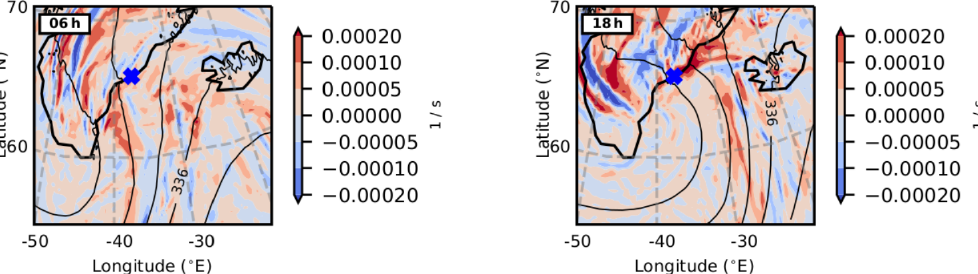
Figure 10. Divergence for CTL-run at 6 and 18h after model initialisation. The divergence is indicated at 8.2km to correspond to the cross- stream ageostrophic wind at 350hPa in Fig. 9. The overlaid pressure isolines (thin black lines) give an indication of the geostrophic wind direction. The thick black lines, blue cross and times in the top left corner are as in Fig.